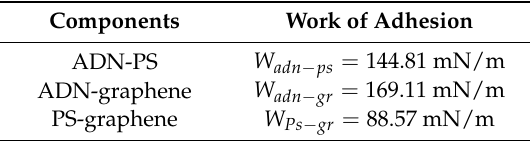
Table 3. Work of adhesion for different components of the system. Table 3 . Work of adhesion for different components of the system . Table 3 . Work of adhesion for different components of the system .